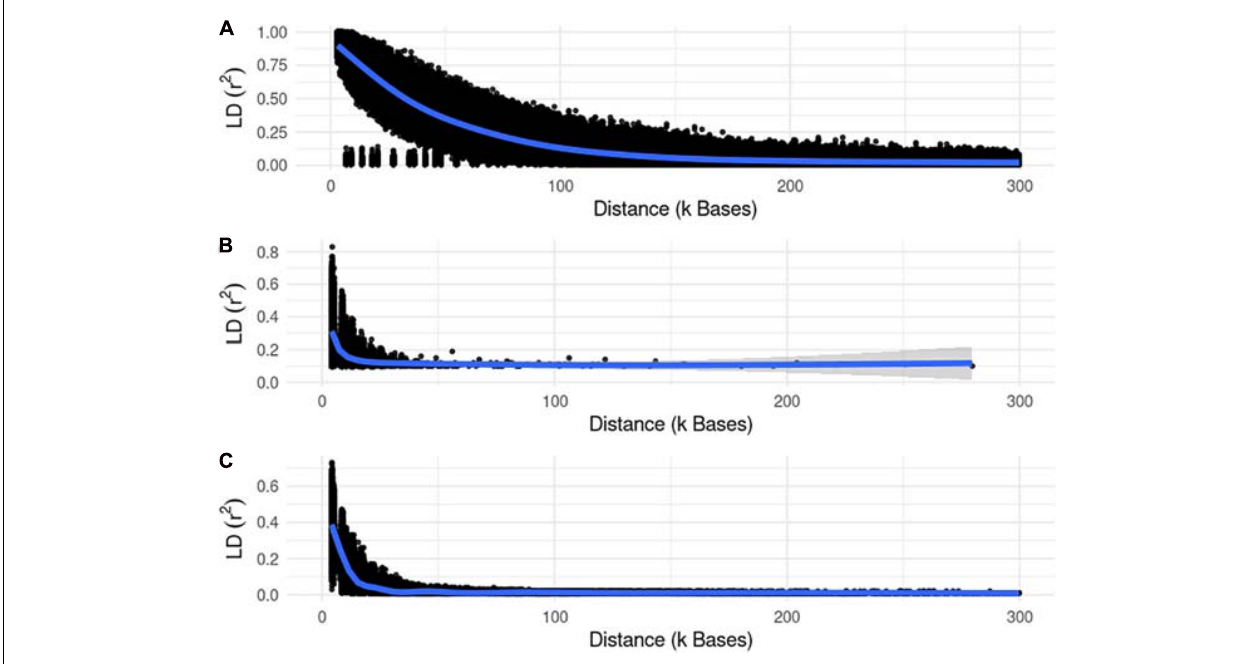
FIGURE 2 | Linkage disequilibrium (r2) decay for the large populations of fish (A) , beef (B) , and dairy cattle (C) .